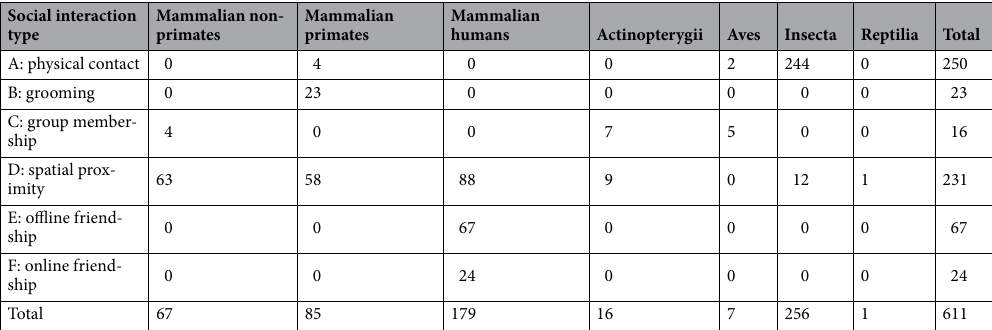
Table 1. Number of networks for each type of social interaction and animal class. In a total of 611 networks, there are 179 cases of human and 432 cases of non-human social interactions, including 281 captive and 151 free-ranging